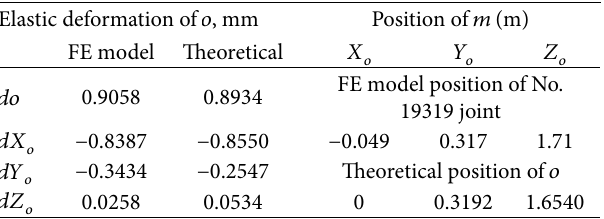
Table 1: Simulation solved results of elastic deformations of EF model of 2SPS + RRPR PM. Elastic deformation of , 𝑜